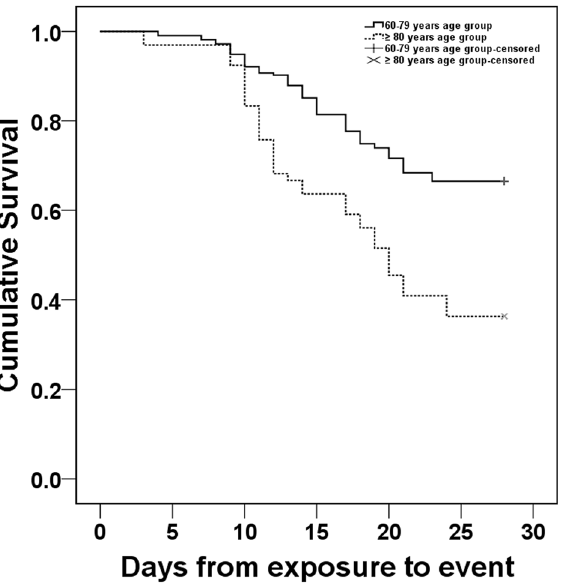
Figure 2. Kaplan–Meier survival curves for patients in the 60–79 years and the ≥ 80 years age groups. Patients in the ≥ 80 years age group had a significantly shorter median survival time compared with patients in the 60–79 years age group (20 days vs. 28.0 days); the log-rank test indicated a significant difference between the two survival curves ( P <